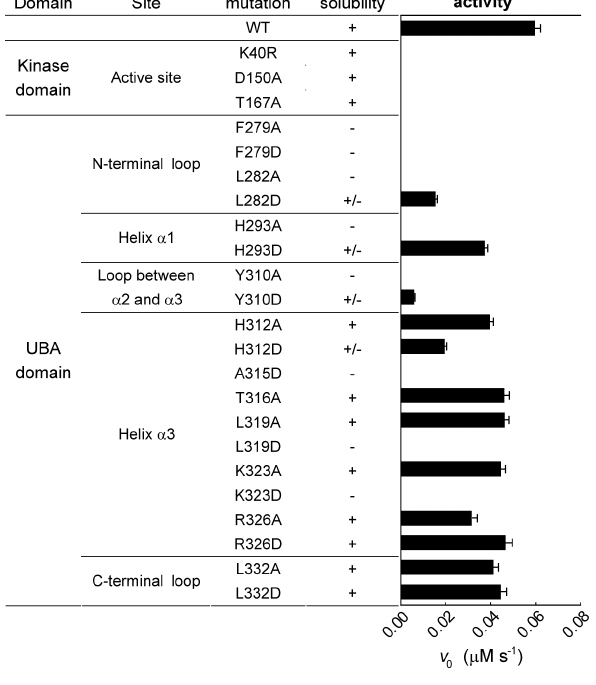
Figure 4. Solubility and activity of MELK KD-UBA mutants. All mutants were overexpressed in E. coli and the soluble proteins were purified to homogeneity as described in the Materials and Methods. The kinase assay was performed in the presence of 10 m M AMARA, 10 mM DTT and 100 nM MELK in standard kinase assay buffer (mean and s.e.m.,